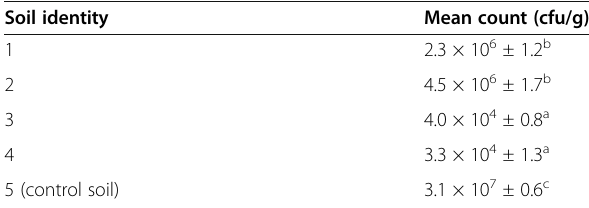
Table 3 Count of aerobic heterotrophic bacteria from soil of sampling sites